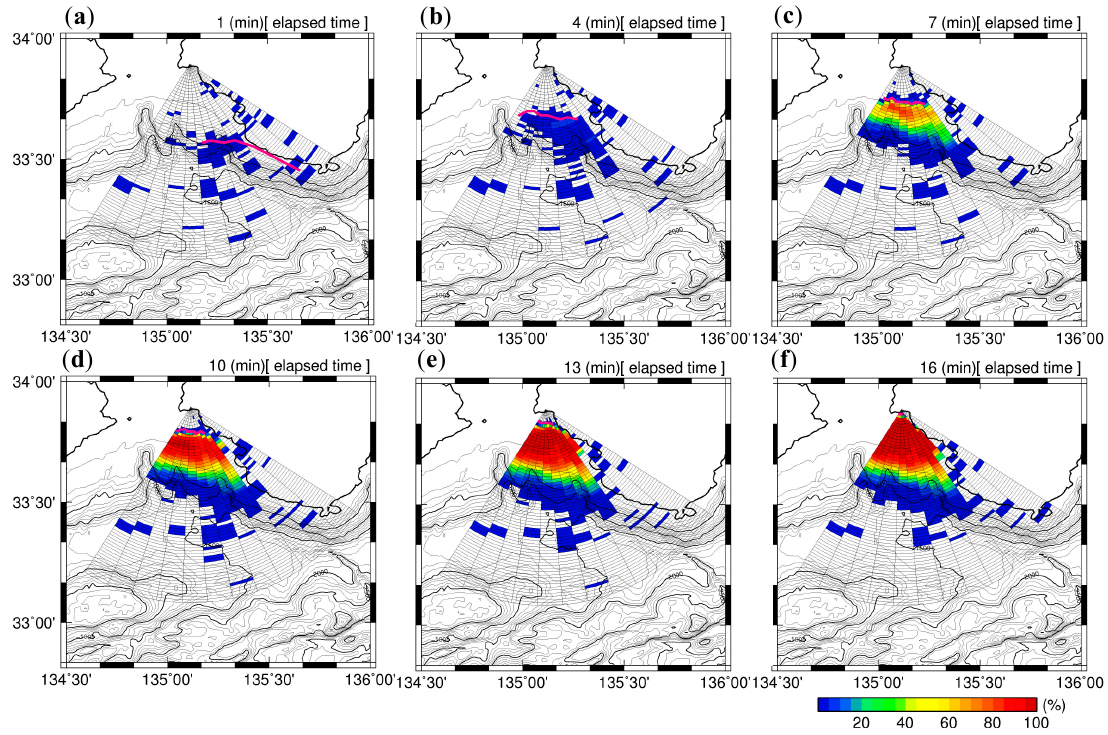
Figure 10. Temporal variations of the detection probability at ( a ) 1, ( b ) 4, ( c ) 7, ( d ) 10, ( e ) 13, and ( f ) 16 min after tsunami occurrence, and the depth contours of the Kii Channel. The background color represents the detection probability, and the pink line represents the first leading wavefront of the tsunami, m f ( b , t )